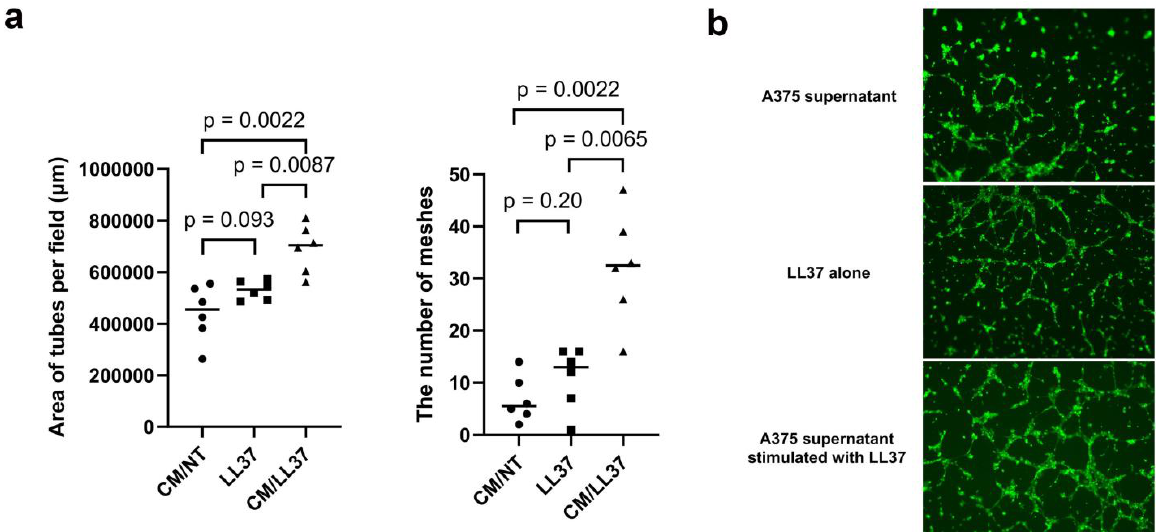
Figure 5. The tube formation assay was performed by applying HDMECs treated with culture supernatant of recombinant LL-37-treated A375 or culture medium with or without recombinant LL-37 onto the Matrigel and incubating for 24 h. To eliminate the effect of proliferation, cells were treated with mitomycin C before the assay ( a ). Representative images are shown ( b ) (n = 5 for each group).